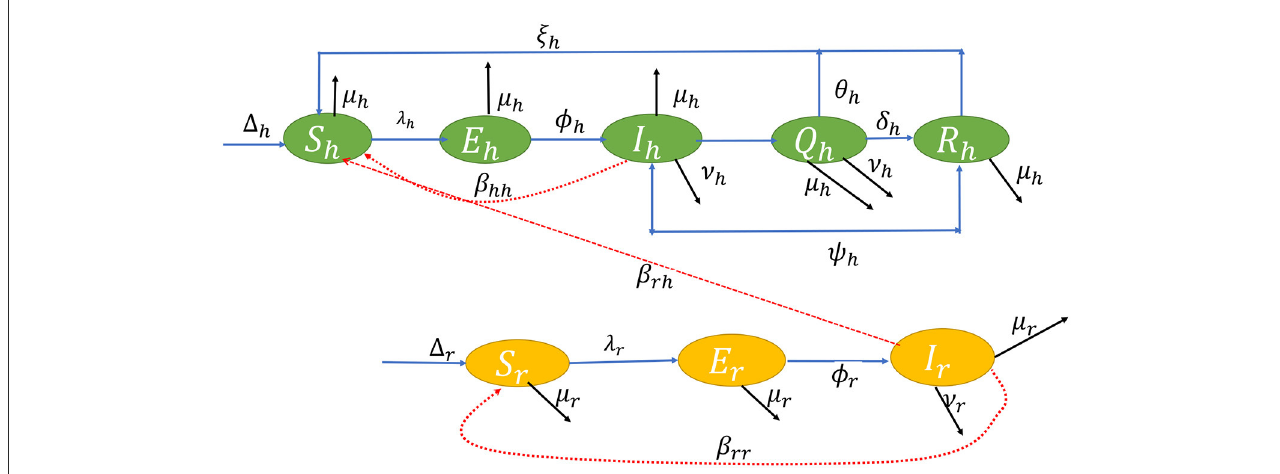
FIGURE1 Transfer diagram of the dynamic transmission of the monkeypox